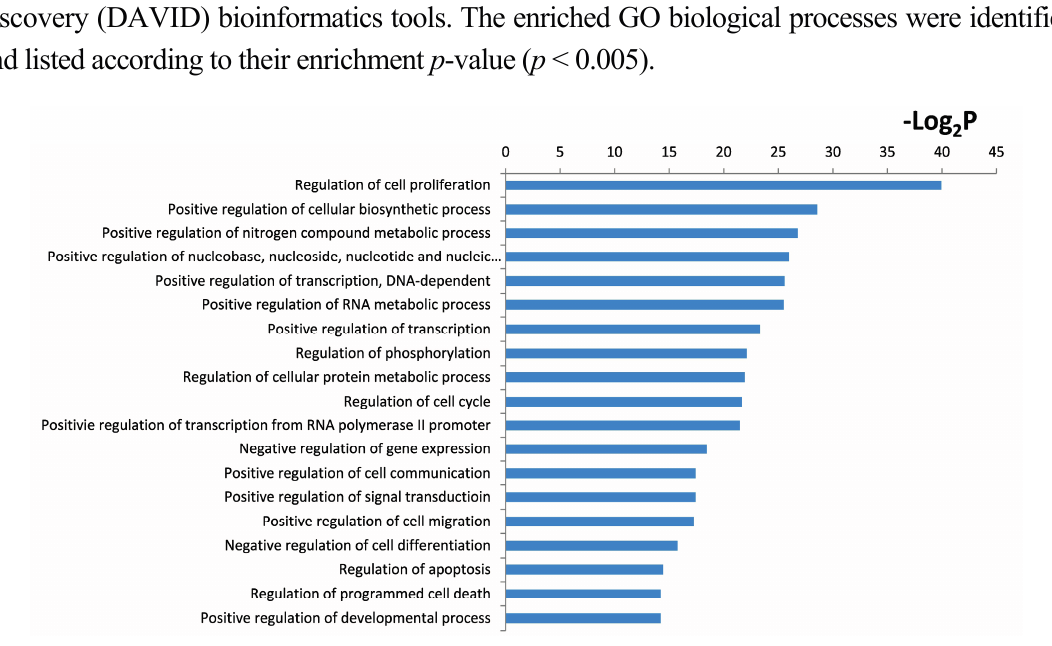
Figure 4. Gene Ontology (GO) analysis within the target genes of significantly altered miRNAs